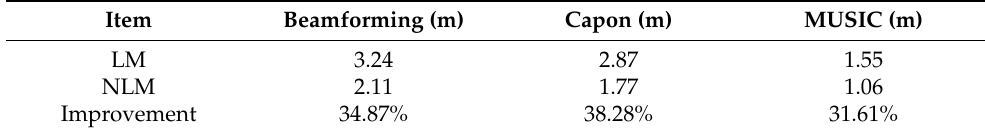
Table 4. RMSE comparison of the different methods used for the profile